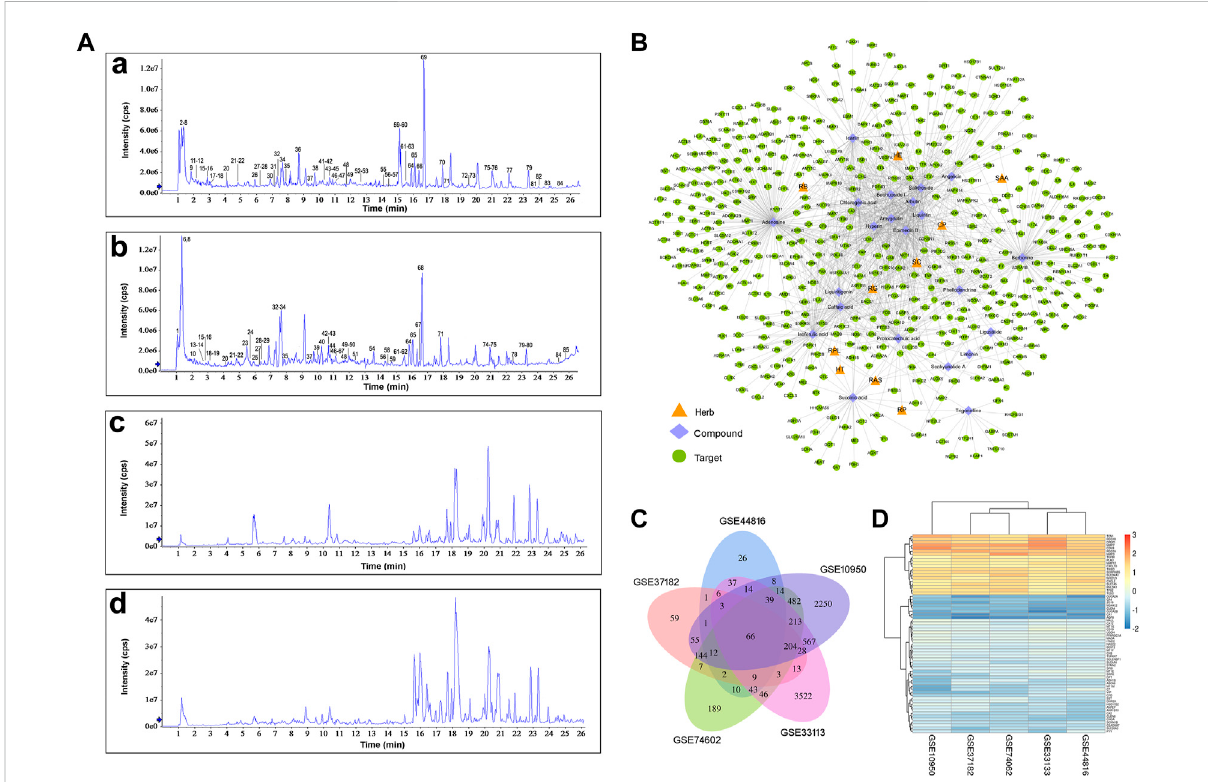
FIGURE 2 Collection of CQF-related targets and CRC-related targets. (A) Total ion chromatographs of CQF samples. a, CQF decoction in ESI + mode; b, CQF decoction in ESI − mode; c, CQF medicated serum in ESI + mode; d, CQF medicated serum in ESI − mode. (B) Herb-compound-target network. The network diagram was constructed by connecting Chinese herbs, active compounds, and potential targets. CP: Cortex phellodendri ; SC: Semen cuscutae ; RG: Radix glycyrrhizae ; HT: Herba taraxaci ; RPL: Radix pseudostellariae ; RP: Rhozoma pinelliae ; RAS: Radix angelica sinensis ;